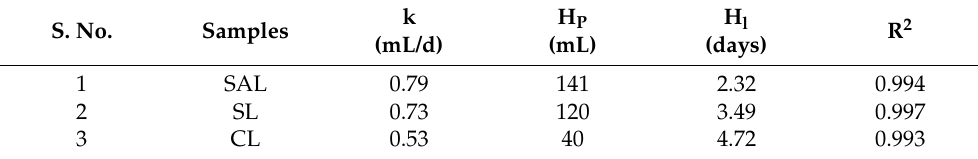
Table 2. Kinetic analysis for various liquefied samples through Gompertz modelling. S. No. Samples